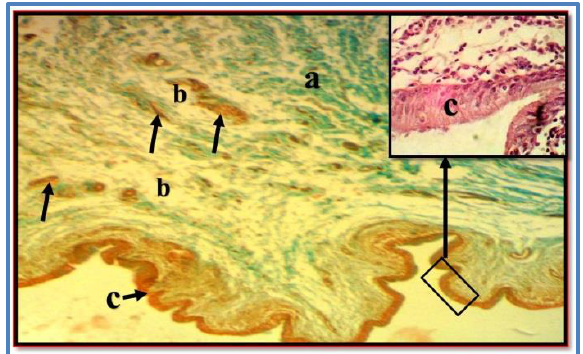
Figure,8: Histological section in the lateral lymphatic body of phallus of guinea fowl showing a- collagen fiber b- space between collagen fibers c- lining epithelium of proctodeum (pseudostratified columnar epithelium ), (arrows)-muscle fibers. Masson's Trichrome stain